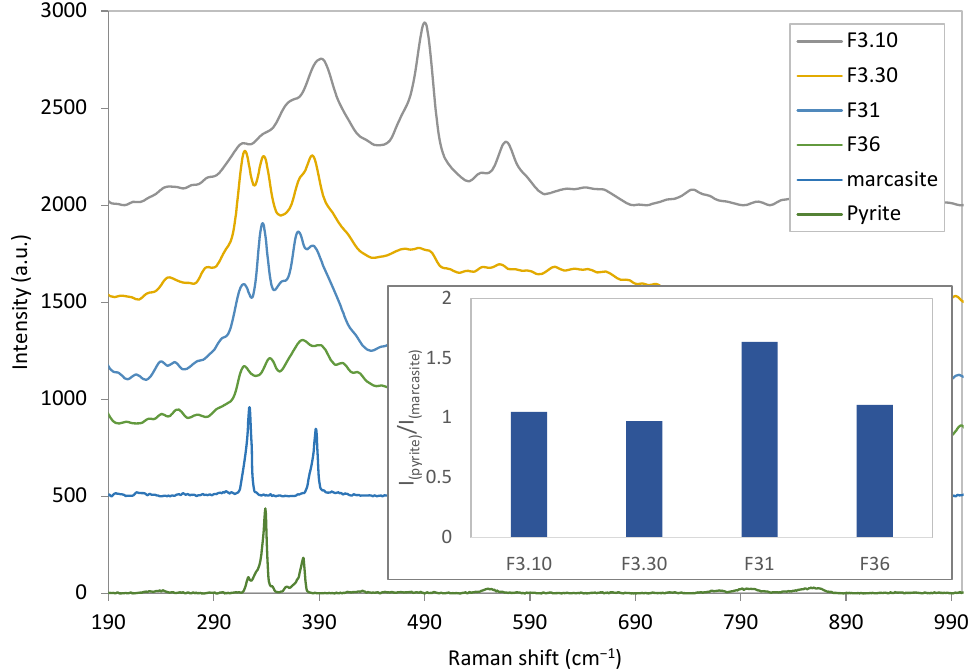
Figure 14. Raman shift for samples with different sulfurization times with reference Raman shifts of pyrite and marcasite. The inset is the chart of relative Raman first peak intensities of pyrite and marcasite for different samples.